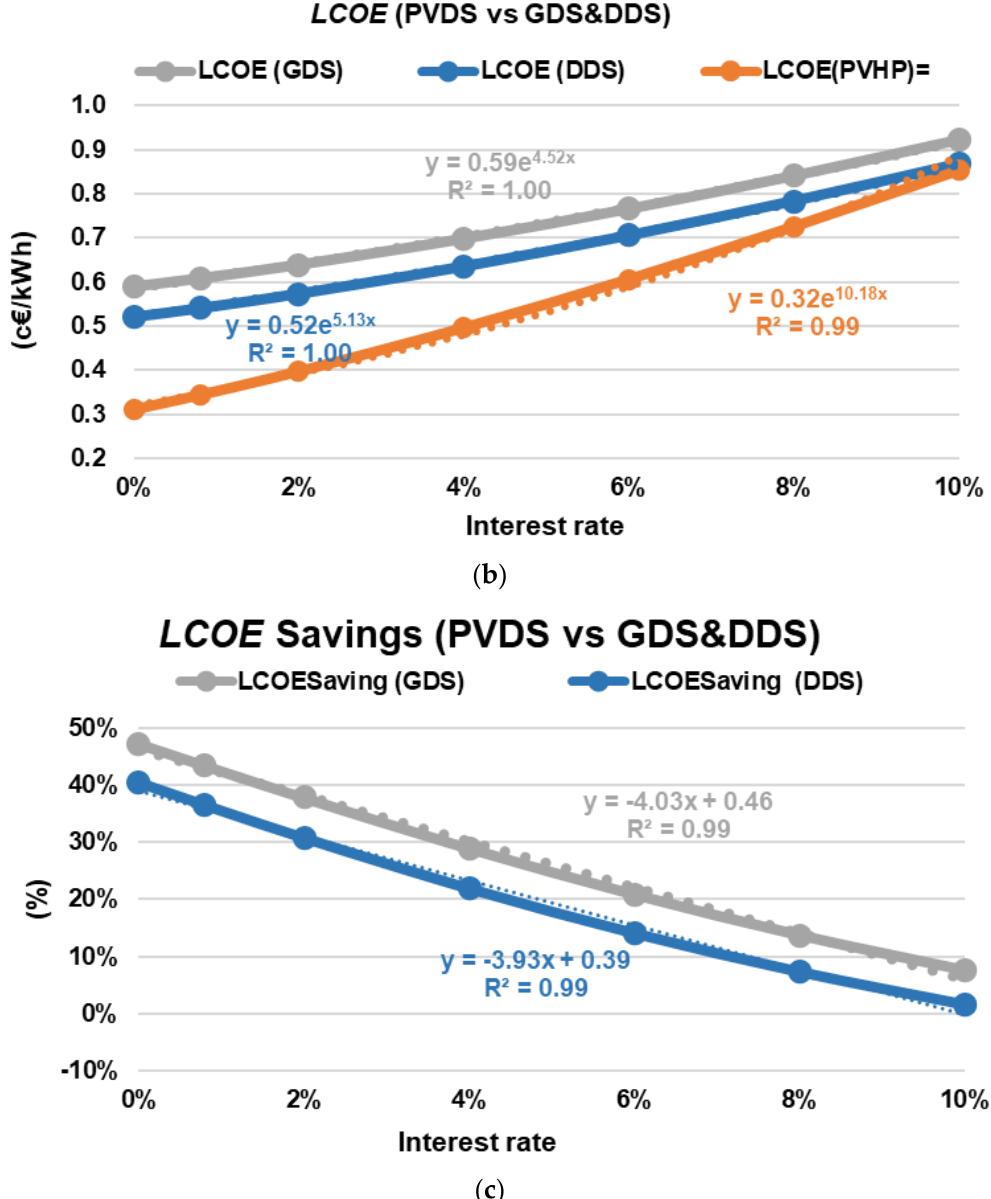
Figure 5. Profitability index ( a ), levelized cost of energy ( b ), and LCOE savings ( c ) obtained for an interest rate between 0% and 10% for the cases PVDS vs. DDS and PVDS vs. GDS.